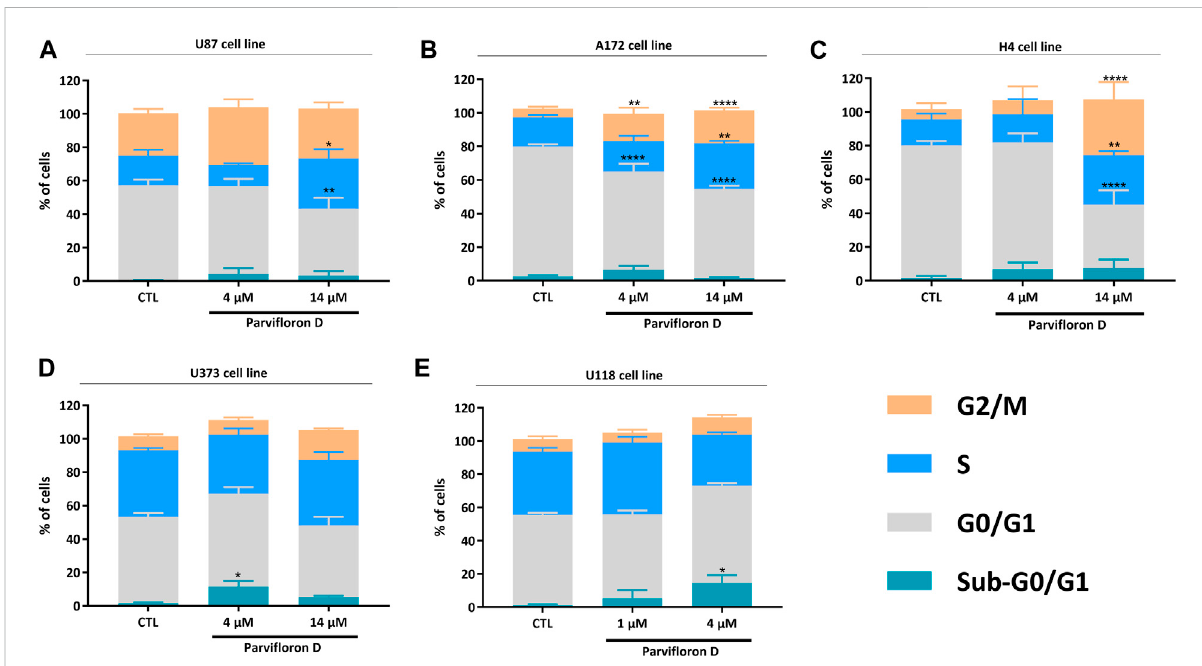
FIGURE 4 Evaluation of parvi fl oron D treatment on cell cycle progression in U87 (A) , A172 (B) , H4 (C) , U373 (D) , and U118 (E) cell lines. Cells were treated with parvi fl oron D for 48 h. After incubation, cells were stained with PI/RNase and the cell cycle was assessed by fl ow cytometry. The proportion of cells in subG0/G1, G0/G1, S, and G2/M cell cycle phases was expressed as a percentage of the total cell population. Asterisks (* p < 0.05, ** p < 0.01, and **** p < 0.0001) represent the values that signi fi cantly differ from the values obtained for the control condition (untreated cells). Data are representative of at least fi ve independent experiments and are expressed as mean ± SD.